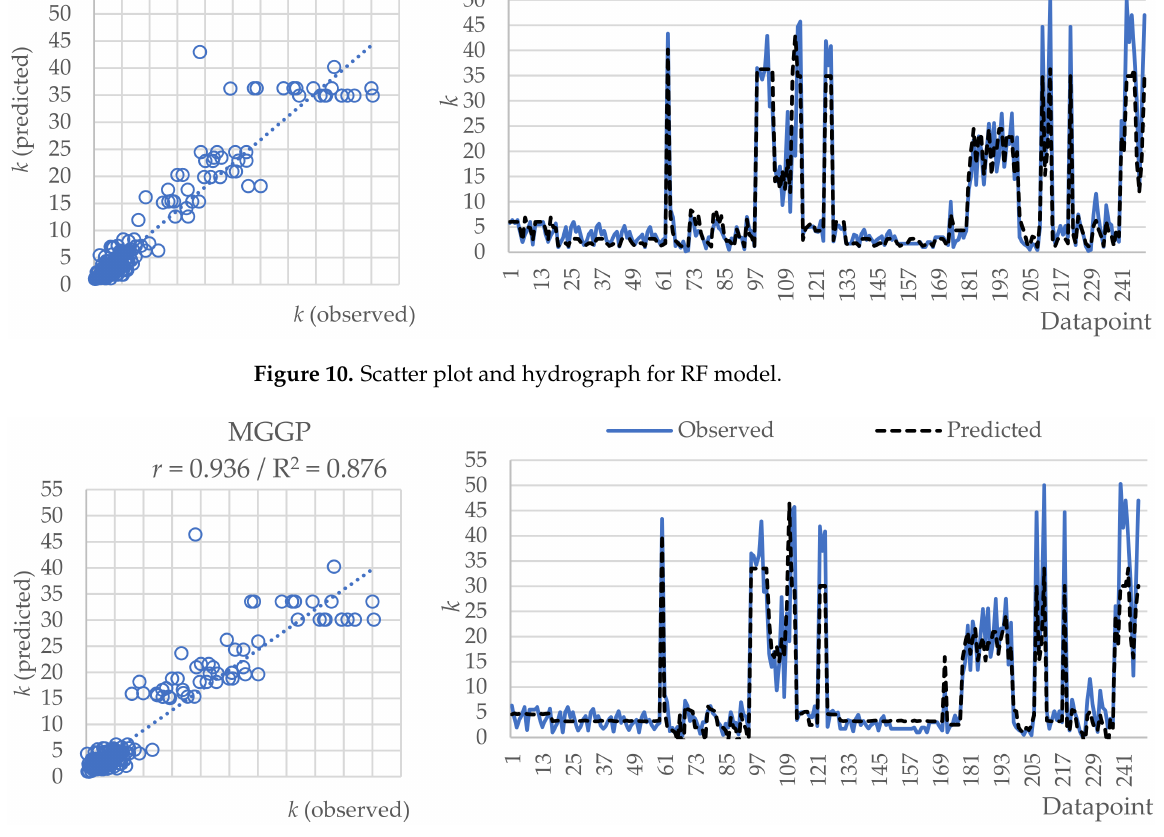
Figure 11. Scatter plot and hydrograph for MGGP model.